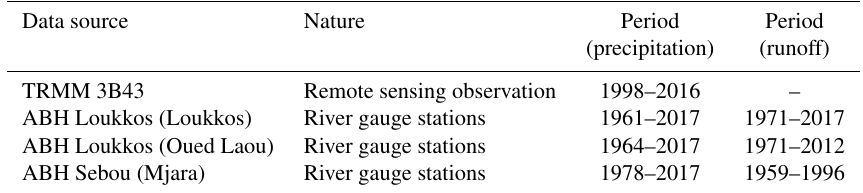
Figure 4. Mapping of the elevation and the position of gauge stations in the Oued Laou, Loukkos and Mjara watersheds. Table 2. Datasets used for the